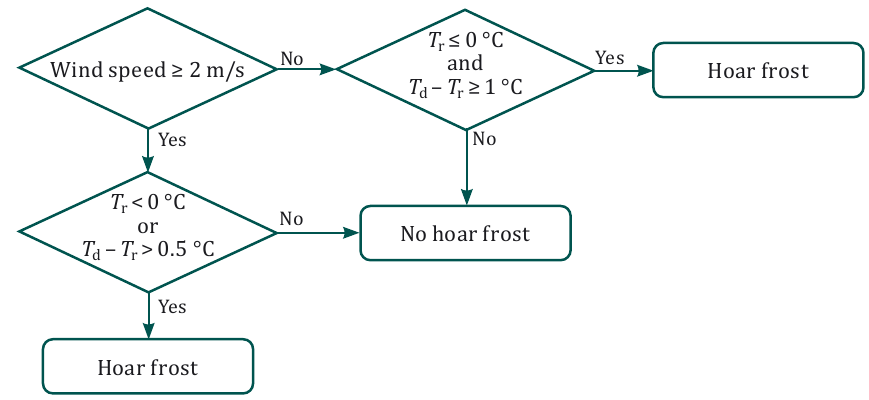
Figure 2. Black ice caused by hoar frost